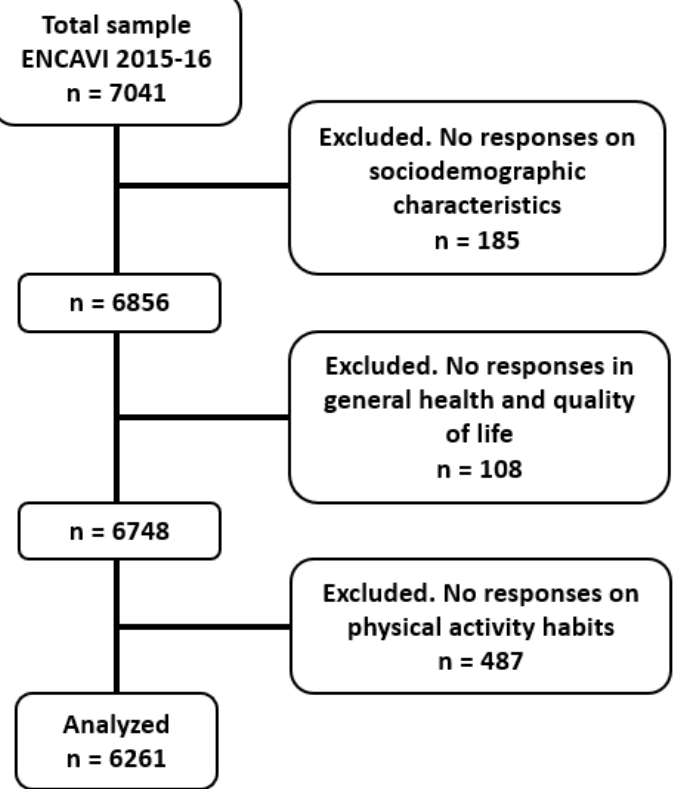
Figure 1. Participants’ flow to achieve the sample size ( n = 6261).